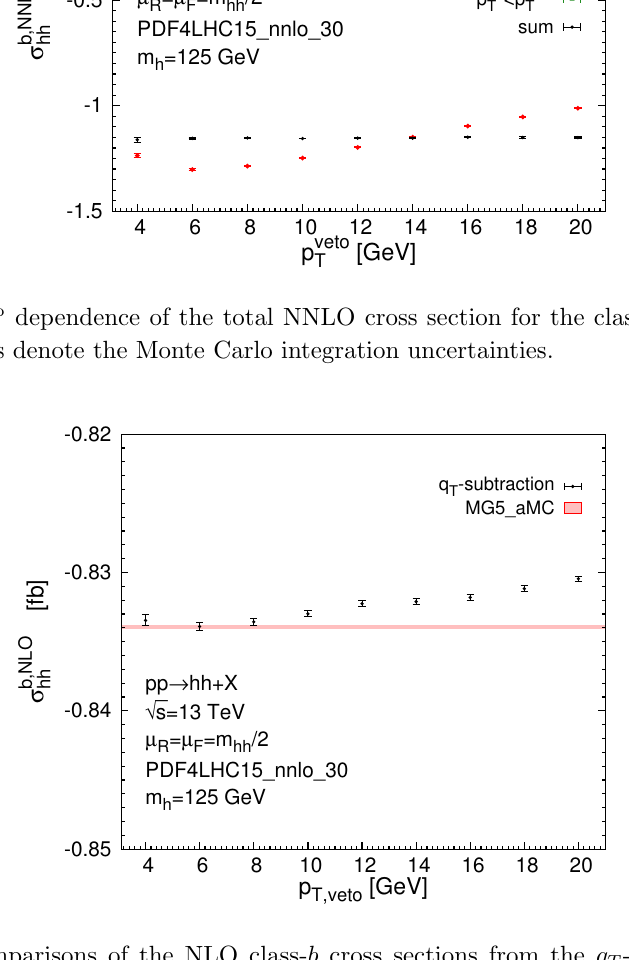
Figure 6 . The comparisons of the NLO class- b cross sections from the q T -subtraction method p (error bars) and MG5 aMC (red band) at s = 13 TeV LHC. The error bars and the band denote the Monte Carlo integration